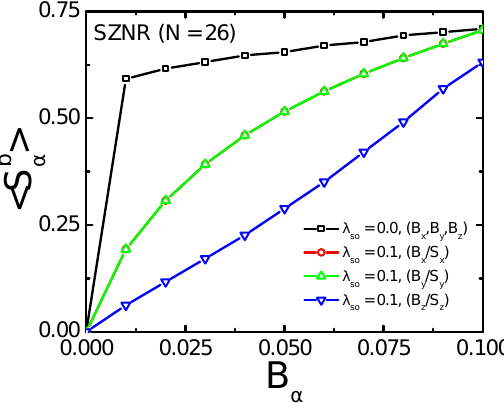
Figure 4. Band polarization (cid:104) S b α (cid:105) for α = x , y , z , as a function of magnetic field applied along the coordinate axes. The black curve is for vanishing SOC (thus the results are independent of magnetic field orientation), while the red, green, and blue curves are for magnetic field applied along the x -, y -, and z -axis, respectively, for λ SO =